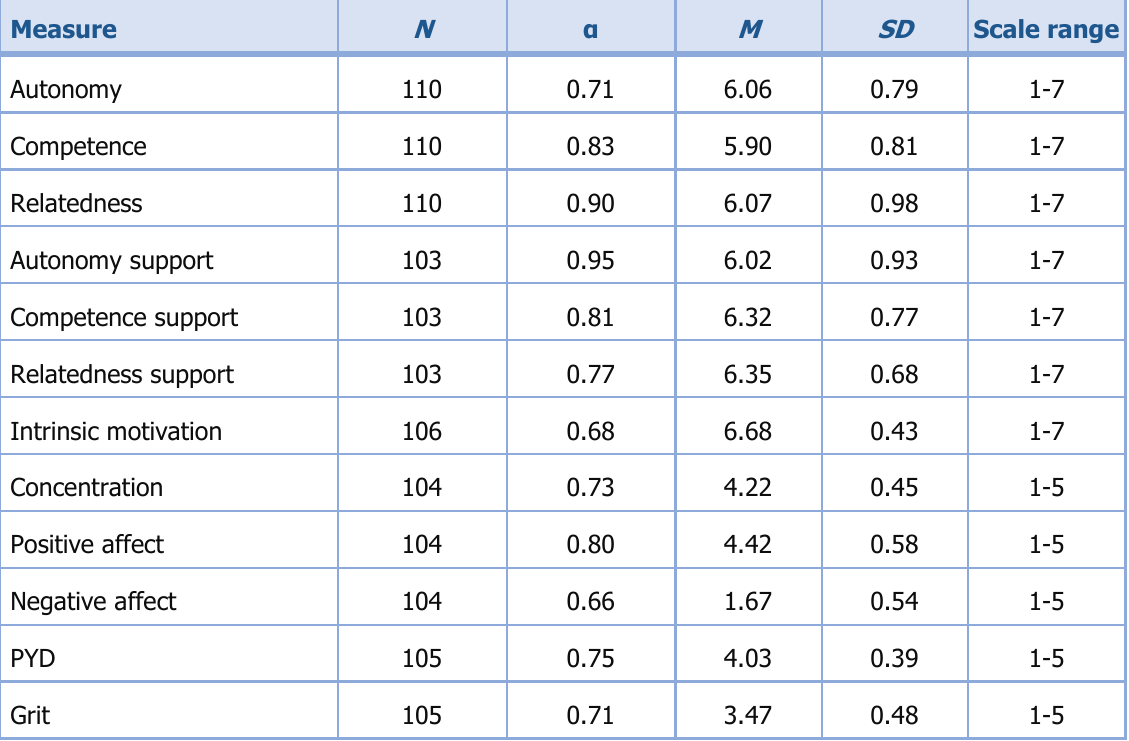
Table 1. Internal Consistency (Cronbach’s Alpha) and Descriptive Statistics for Each